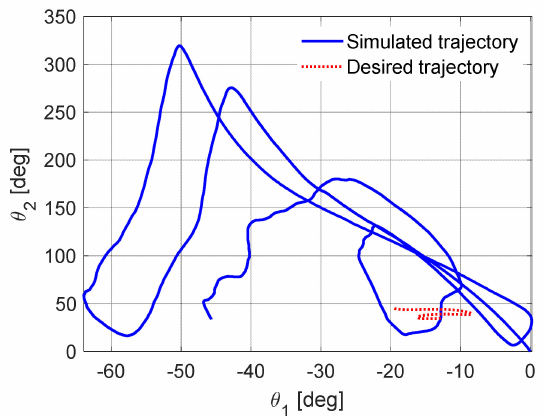
Figure 12. Simulated and desired trajectory of ARS with random interference—PID control.